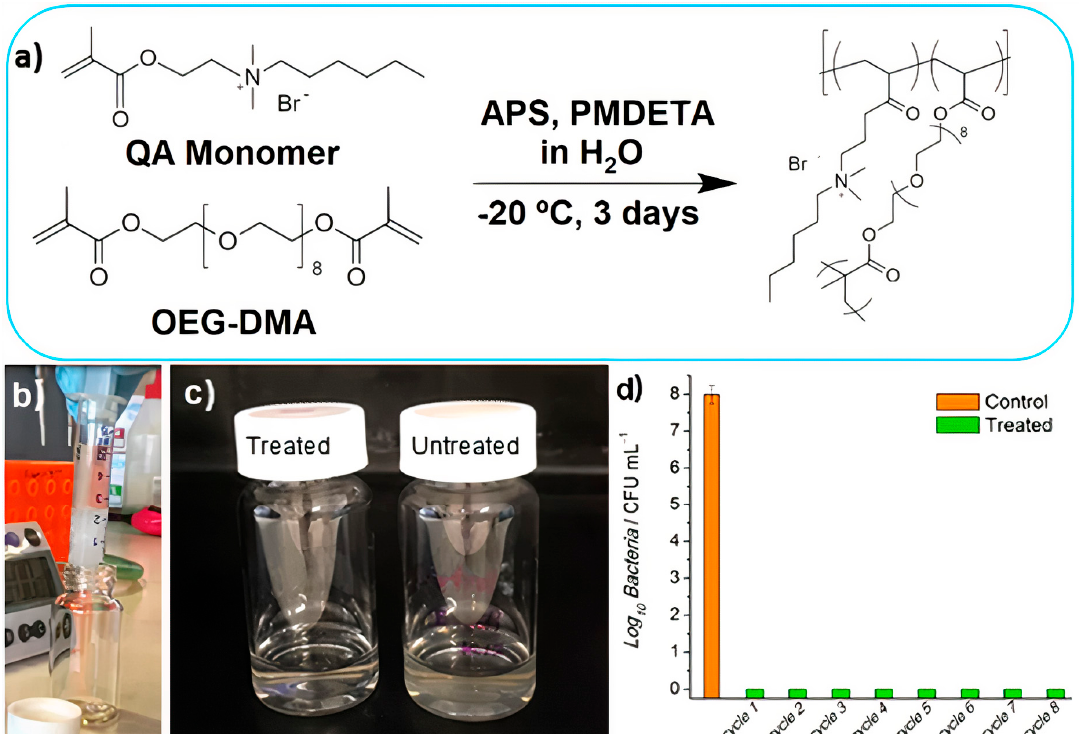
Figure 14. Macroporous antimicrobial polymeric gel (MAPG) for water treatment. ( a ) MAPG synthesis via free radical polymerization at subzero temperature. ( b ) Image of macroporous antimicrobial polymeric gel (MAPG) in a syringe and E. coli − contaminated water passing through it. ( c ) Image of treated water after passing through the syringe. Compared to the untreated, cloudy water due to the presence of bacteria, the treated water was clear. ( d ) The syringe was subjected to 8 continuous cycles of percolation with E. coli − contaminated water; the recovered water was analyzed via colony − forming unit (CFU) counting. No viable bacteria were detected in the water that passed through the syringe. APS is ammonium persulfate, QA monomer is the quaternary ammonium ethyl methacrylate monomer, PMDETA is the coinitiator N,N,N ′ ,N ′′ ,N ′′− pentamethyldiethylenetriamine, and OEG − DMA is oligoethylene glycol dimethacrylate. Adapted from [189].